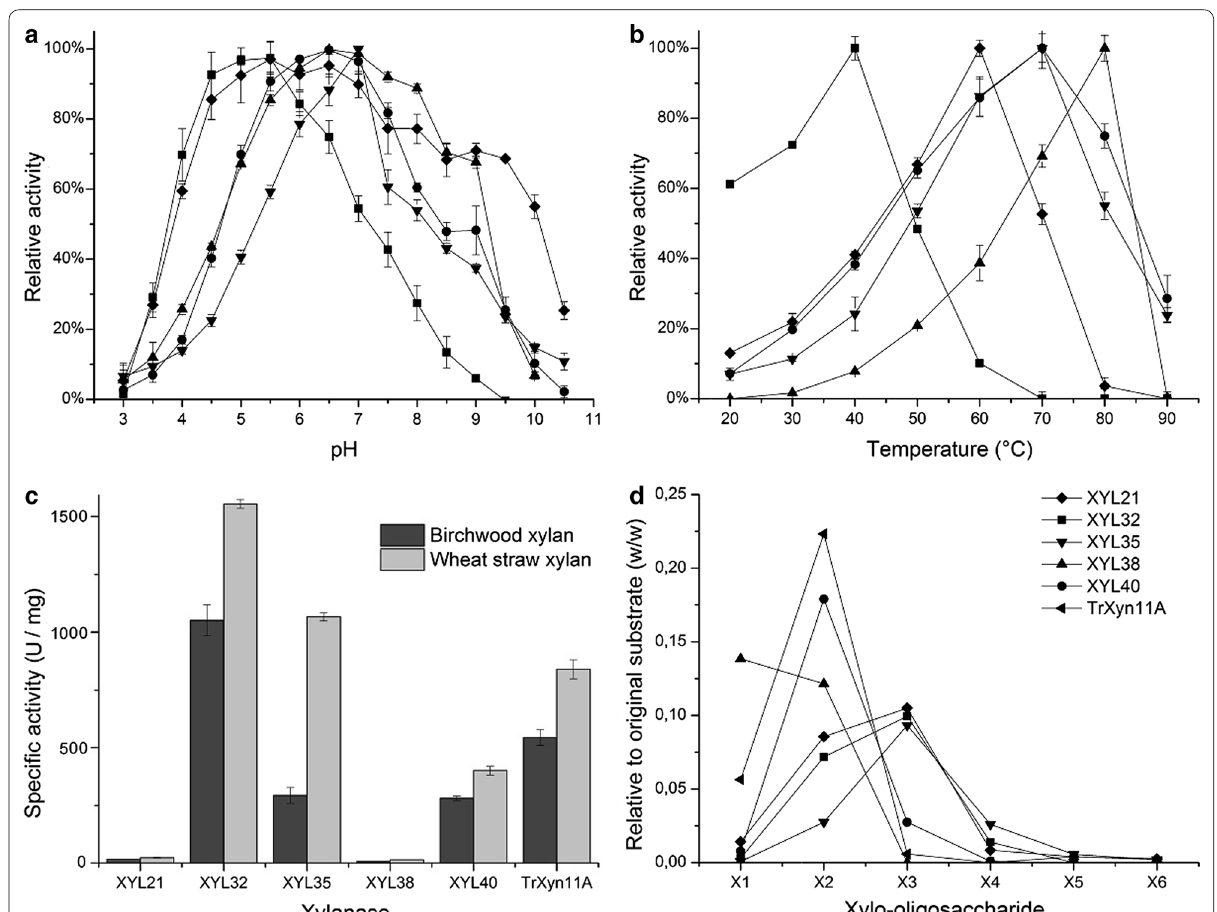
Fig. 3 Preliminary characterization of the purified recombinant xylanases. a The relative activity of the purified recombinant xylanases on birchwood xylan as a function of pH. b Temperature optima were measured by conducting the standard xylanase assay at different temperatures over a range of 20 °C to 90 °C. c Specific activity of the purified xylanases on birchwood glucuronoxylan (GX) and wheat arabinoxylan (AX). d